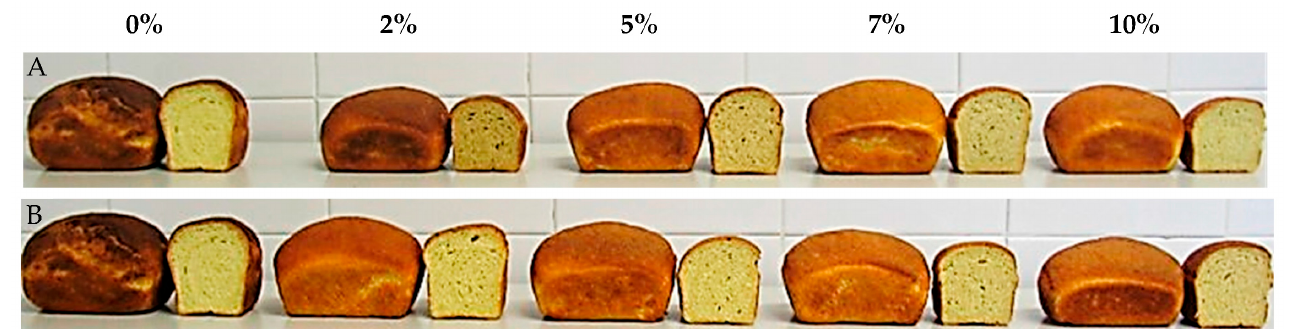
Figure 2. Experimental groups of bread loaves with ( A ) 0%: semolina sample (ctrl), 2%: 2% barley flour powder addition, 5%: 5% barley flour powder addition, 7%: 7% barley flour powder addition, 10%: 10% barley flour powder addition or with ( B ) 0%: semolina sample (ctrl), 2%: 2% thin bran flour powder addition, 5%: 5% thin bran flour powder addition, 7%: 7% thin bran flour powder addition, 10%: 10% thin bran flour powder addition.